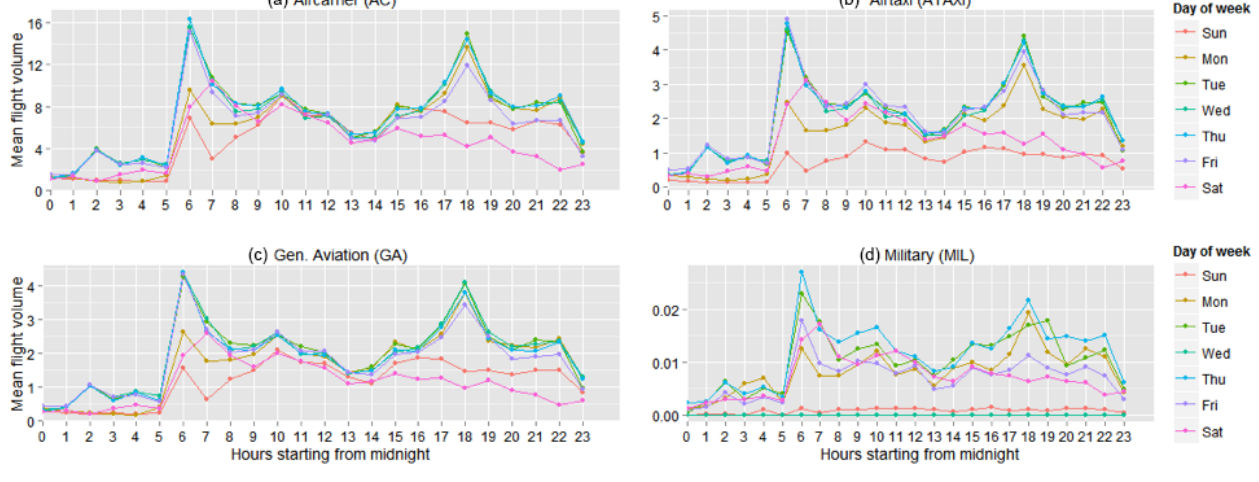
Figure 5. Same as Fig. 4 but for the Ontario (ONT)